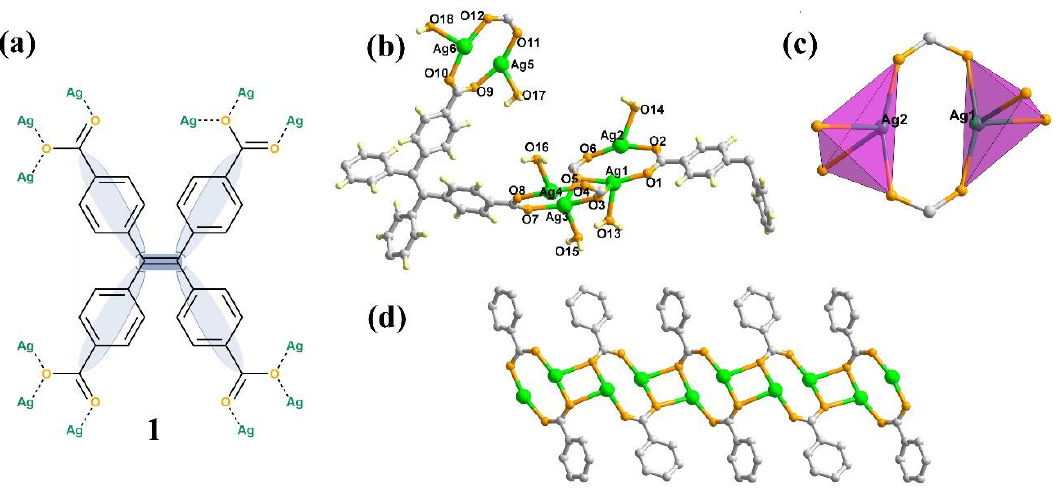
Figure 1. ( a ) The representation of ligand tetrakiscarboxyphenylethylene (TCPE) and the coordinated modes with Ag ions; ( b ) Ball-and-stick representation of 1 in an asymmetric unit with atomic-numbering scheme; ( c ) The coordination environment of Ag1 and Ag2 with tetrahedral fashion; ( d ) Connected mode of Ag chains. Color code: Ag, green; O, orange; C, gray. H atoms are omitted for clarity.